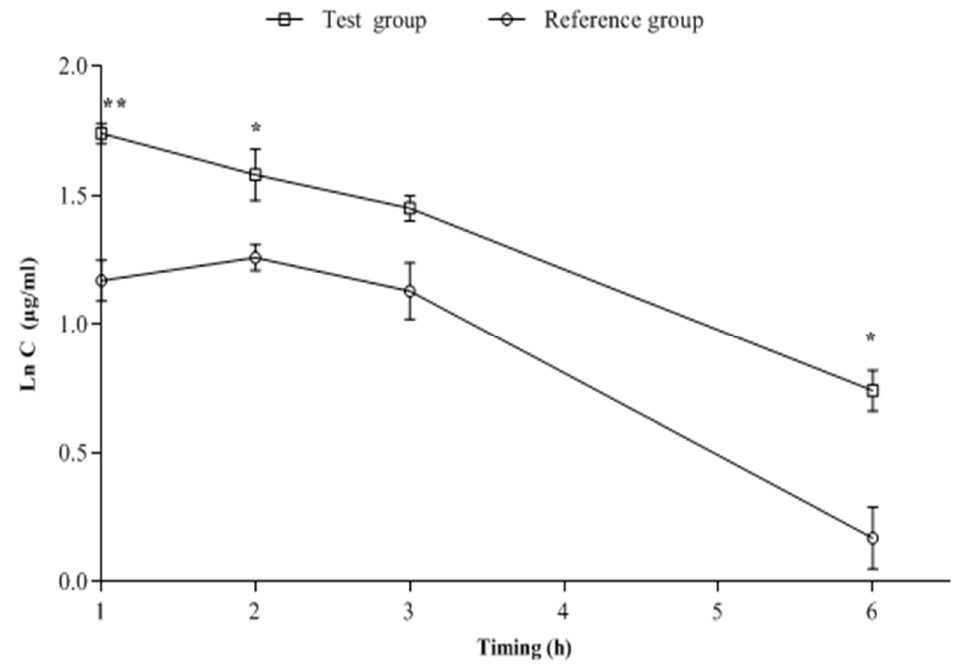
Figure 2. Curves of the mean plasma concentration of AMX for reference and test groups vs. time (h) at a semilogarithmic scale. *: statistically significant difference compared to reference group ( p < 0.05). **: statistically significant difference compared to reference group ( p < 0.01).